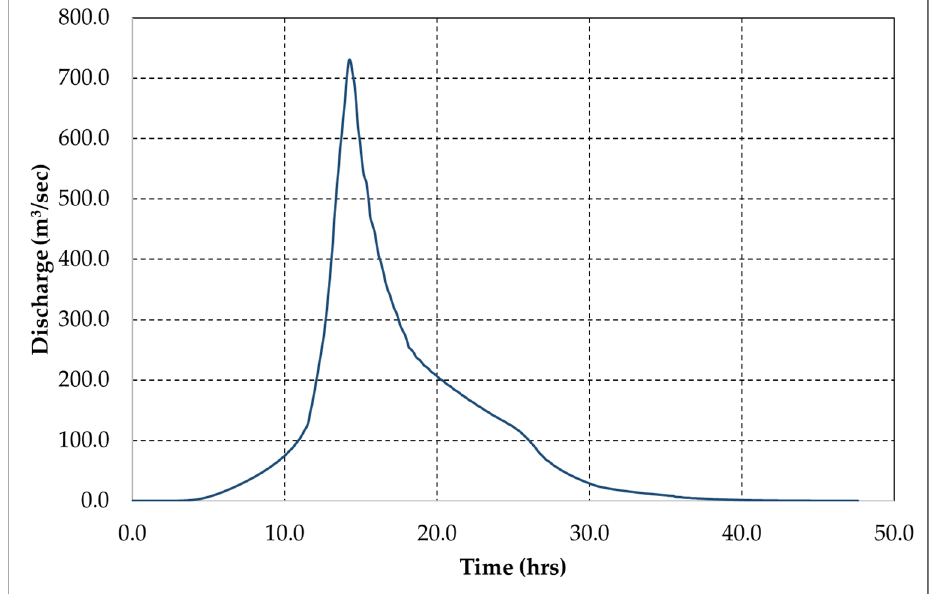
Figure 9. The PMF for the Papadia dam catchment.